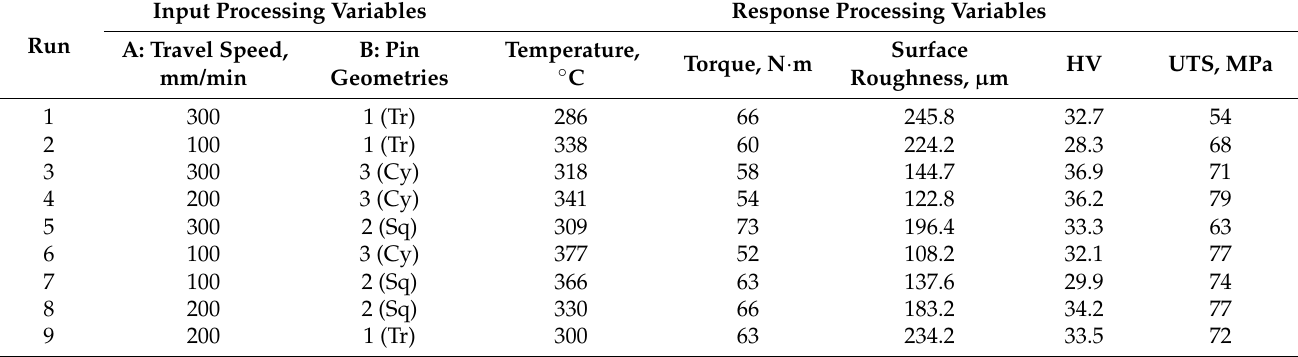
Table 3. Design matrix for 8 mm thickness AA1050